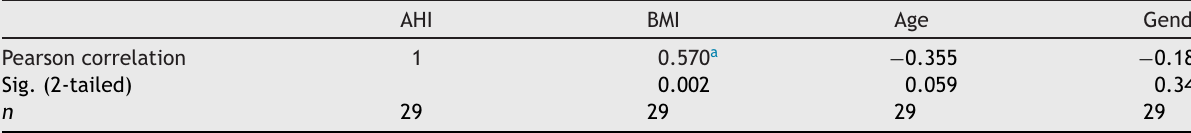
Spearman’s rank correlation coefficient between AHI anthropometric variables.